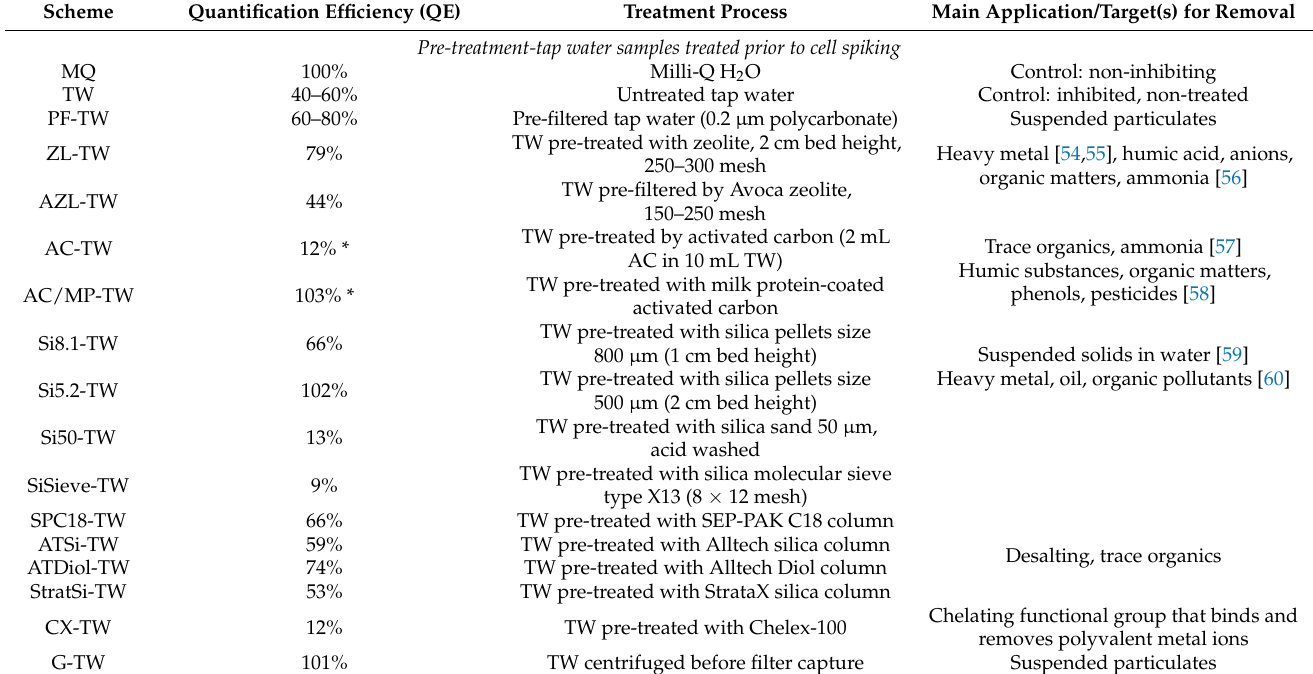
Table 4. Evaluation of the effectiveness of tap water pre-treatment strategies for the removal of inhibitors in 10 mL sam- ples. TW—tap water in. Treatment process of each sample detailed in corresponding column. * Treatment method resulted in filter blockage.